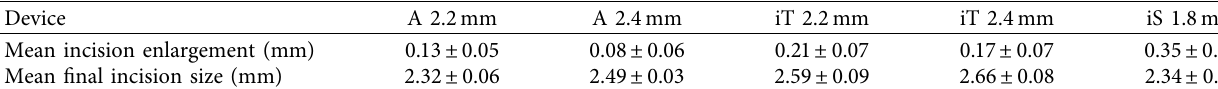
Figure 2: Mean enlargement with sclerocorneal incisions ( ± SD) ( ∗ P < 0 . 05, one-way analysis of variance) (A � AutonoMe; iT � iTec; iS � iSert). Table 5: Mean enlargement and final size of sclerocorneal incisions.